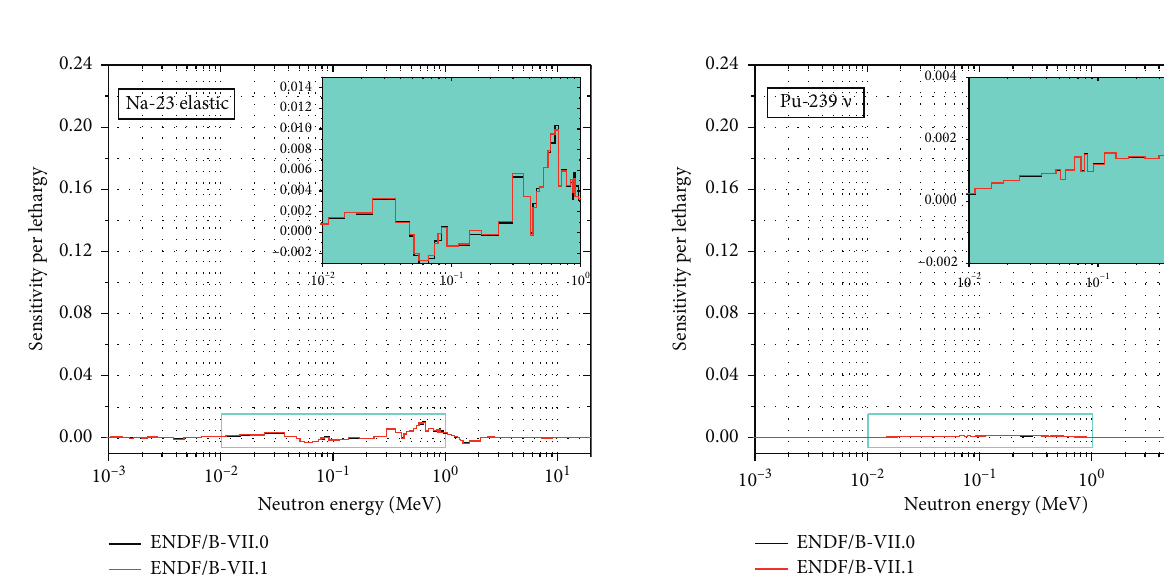
to 239 Pu total ] eff